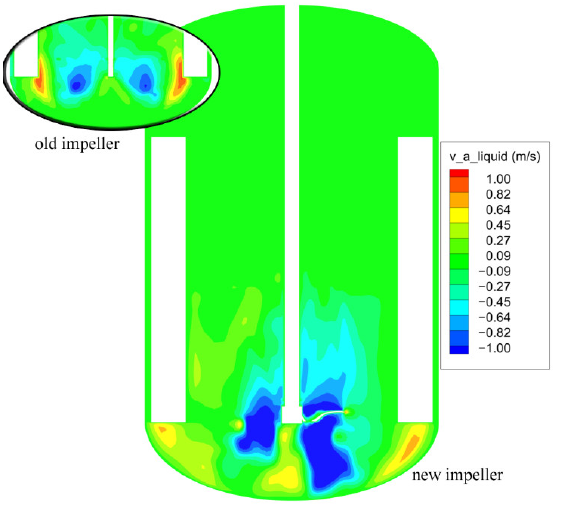
Figure 5. Axial velocity distribution of the liquid phase, old impeller vs. new impeller.